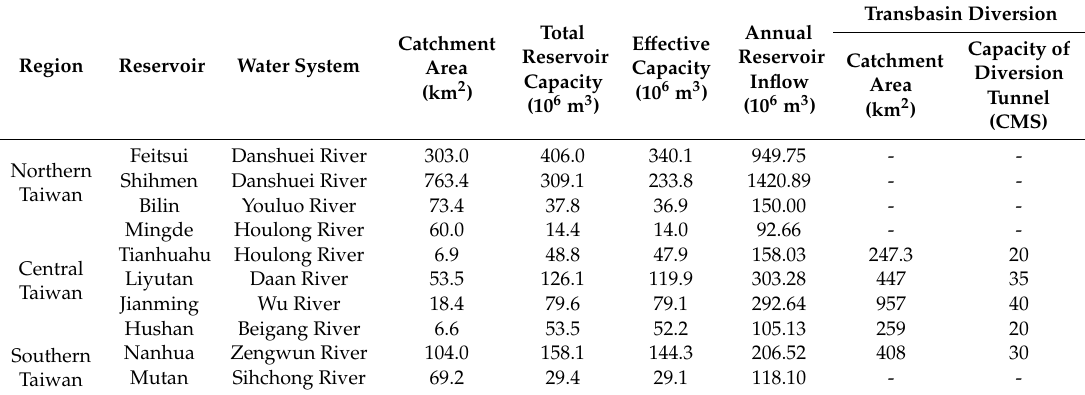
Table 3. Basic information about the selected study